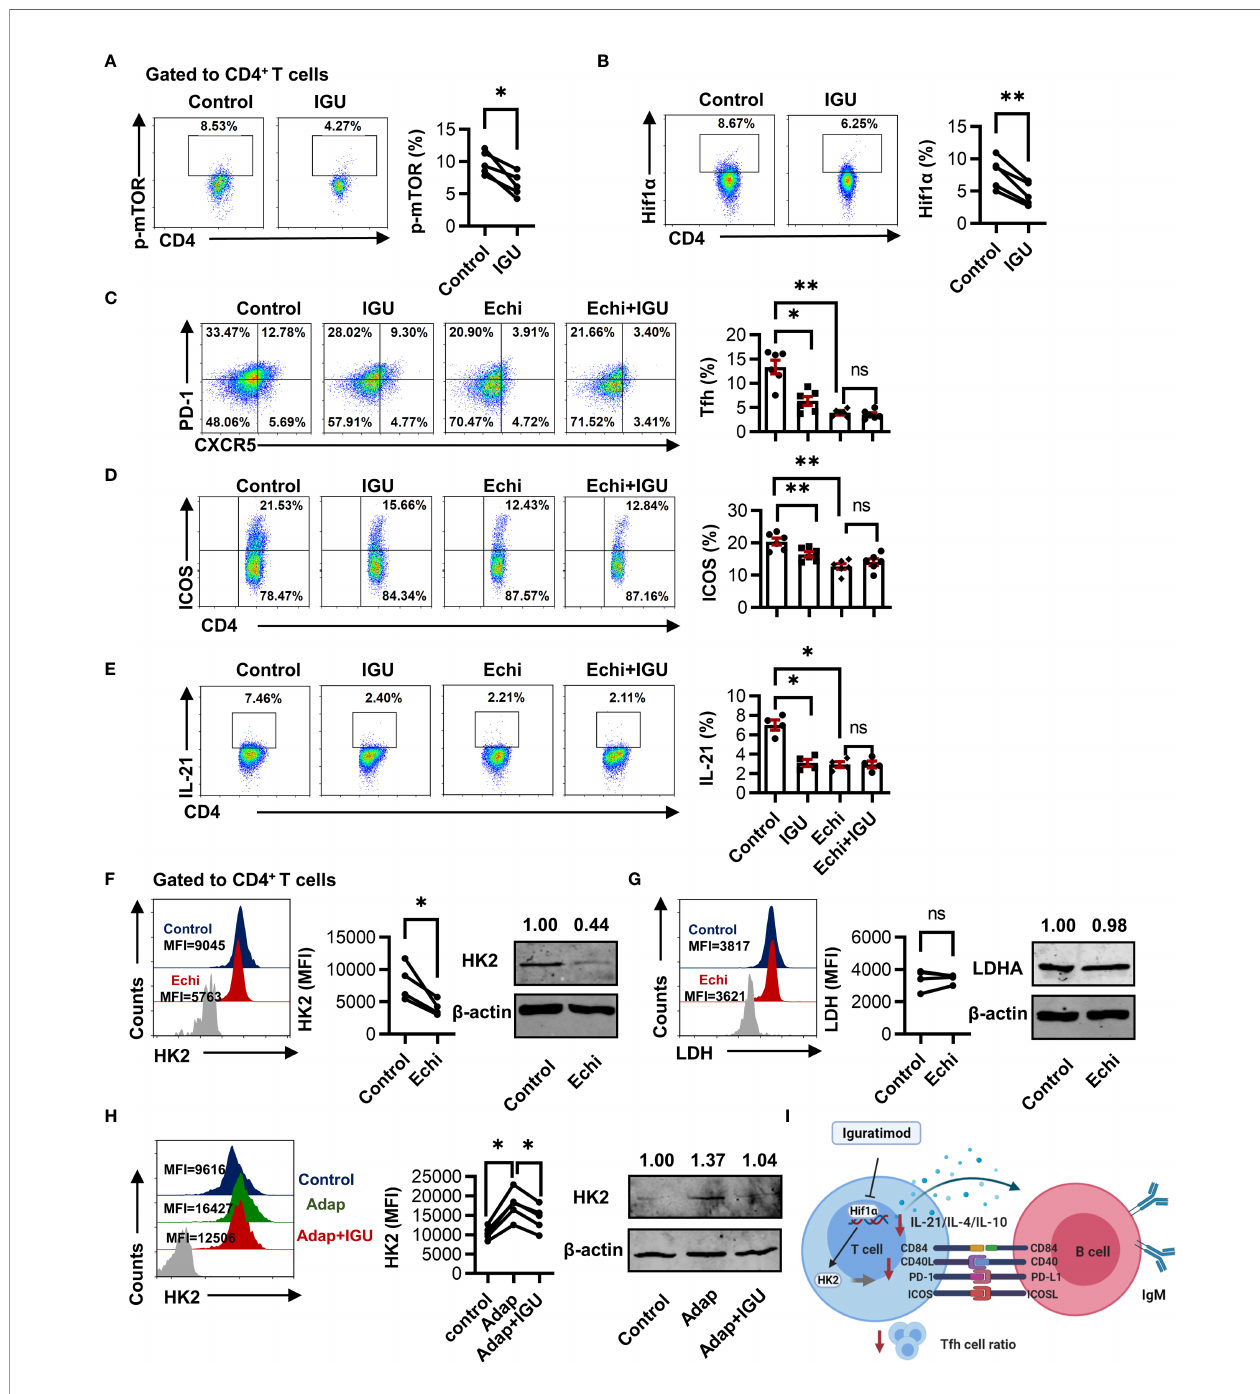
FIGURE 6 | IGU restrains cTfh cell function by inhibiting the Hif1 a -HK2 axis. (A, B) RA-PBMCs were activated by anti-CD3/CD28 antibody (2 m g/ml) and treated with or without IGU for 3 days, and the levels of p-mTOR (A) and Hif1 a (B) were analyzed by fl ow cytometry (n = 5). (C – E) RA-PBMCs were pretreated with anti- CD3/CD28 antibody and Hif1 a inhibitor Echinimycin (Echi) for 4 hours and then treated with IGU or DMSO for 3 days. The frequencies of Tfh cells (n = 6), ICOS + CD4 + T cells (n = 6), and IL-21 producing CD4 + T cells (n = 4) were determined by fl ow cytometry. (F, G) RA-PBMCs were treated with Echinomycin (Echi) for 24 hours, HK2 (n = 4) and LDH (n = 4) in RA-CD4 + T cells were measured. (H) RA-PBMCs were pretreated by anti-CD3/CD28 antibody and Adaptaquin (the activator of Hif1 a ) (5 m M), and then treated with IGU for 72 hours. The expression of HK2 (n = 5) was measured. (I) Schematic depicting the described fi ndings: IGU restrains RA cTfh cell function by inhibiting the Hif1 a -HK2 axis. MFI, mean fl uorescence intensity. ns, no signi fi cance; * P < 0.05; ** P